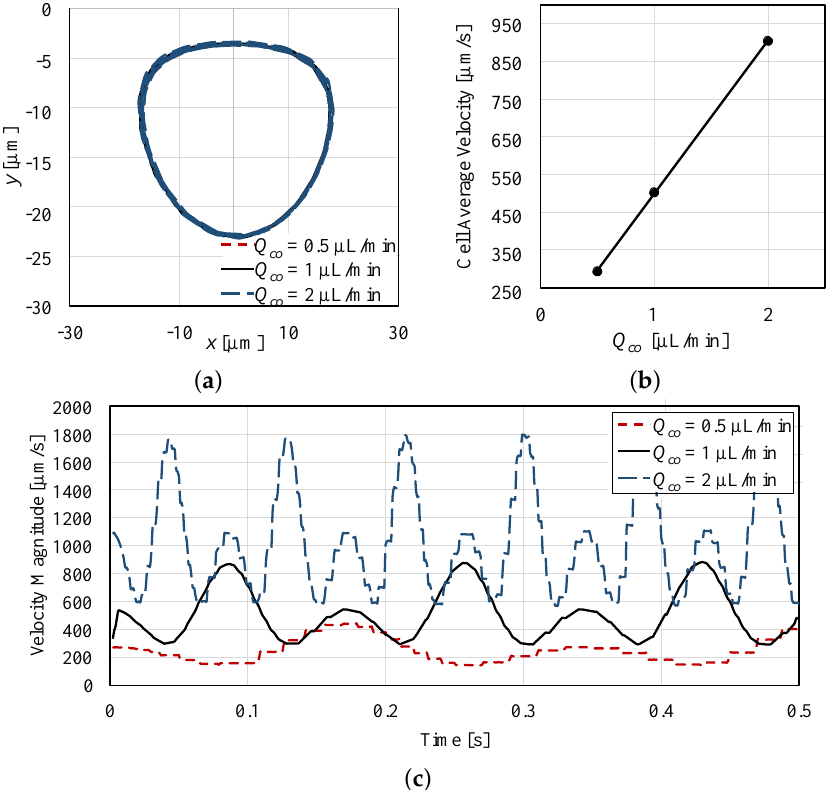
Figure 3. Effect of flow rate on encapsulated cell dynamics: ( a ) cell trajectory, ( b ) cell average velocity, and ( c ) cell velocity